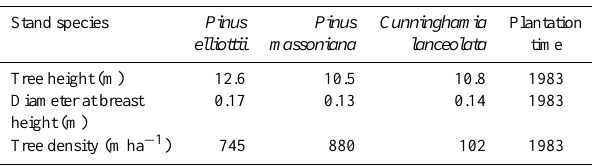
Table 1. Stand characteristics at Qian Yinzhou experiment station in southeastern China ∗